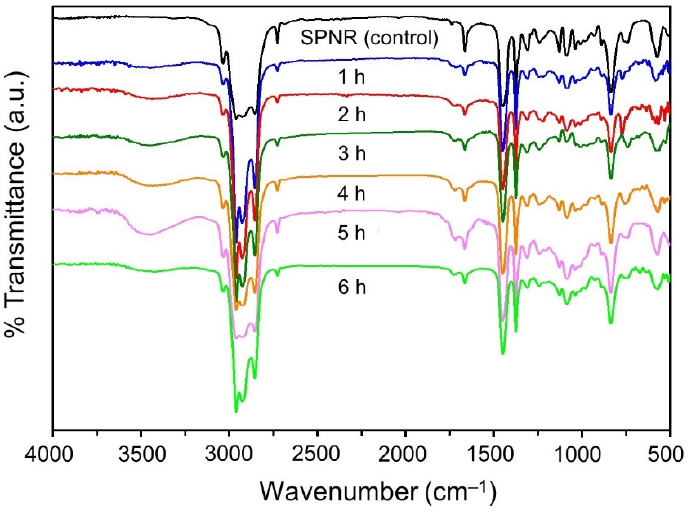
Figure 8. FTIR spectra of SPNR and the samples prepared by introducing 2.0 phr of TiO 2 powder in the presence of 20% w / w H 2 O 2 after various UVC-irradiation times.